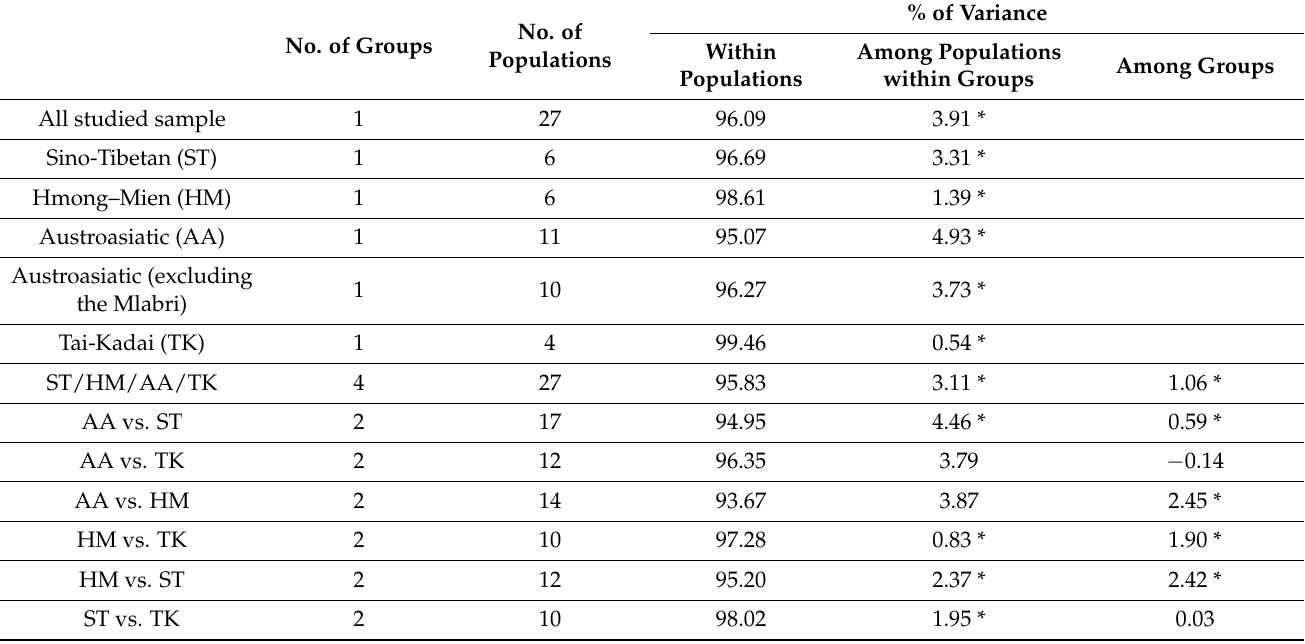
Table 2. Analysis of molecular variance (AMOVA)